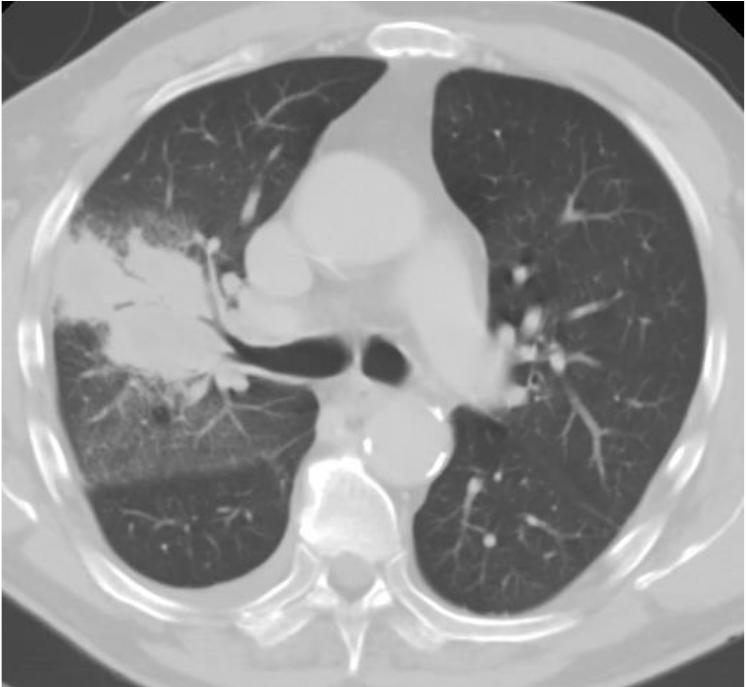
Figure 4. Chest CT of acute pulmonary histoplasmosis showing a large consolidation with air bron- chogram.